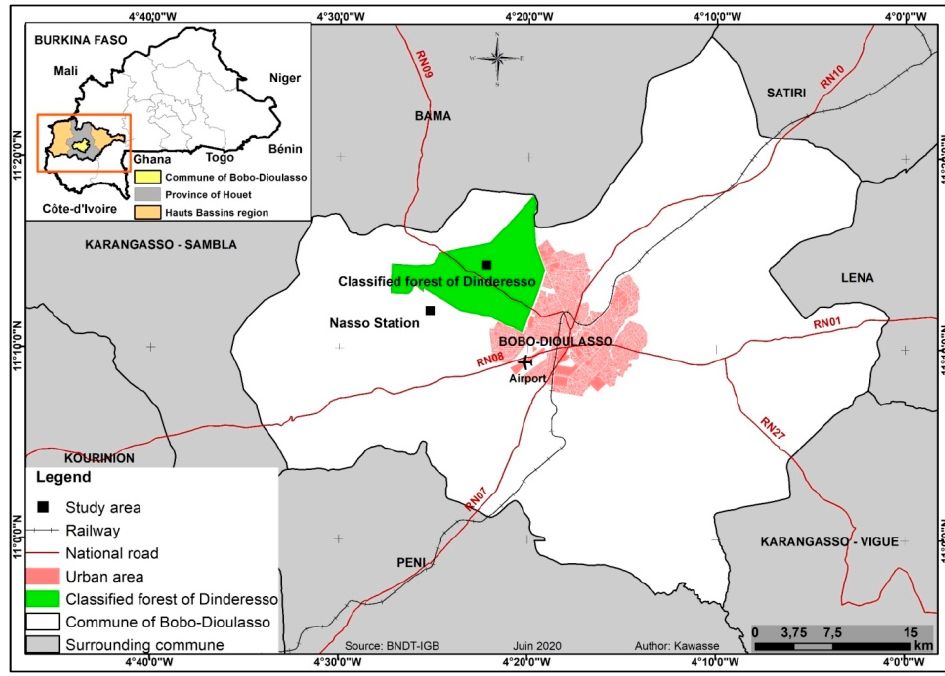
Figure 1. Location of the experimental sites. Source: National Topographic Database-Geographic Institute of Burkina Faso.